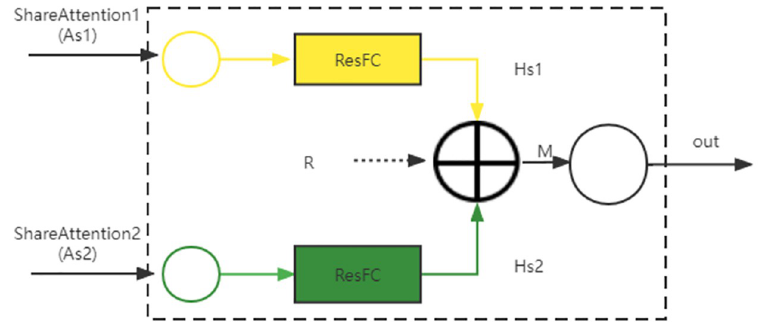
Fig 4. Projection structure